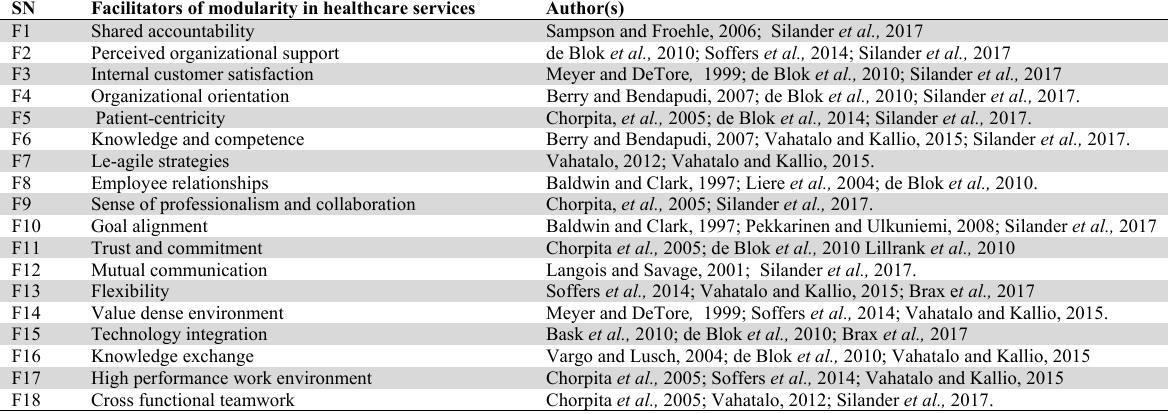
Facilitators of modularity in healthcare